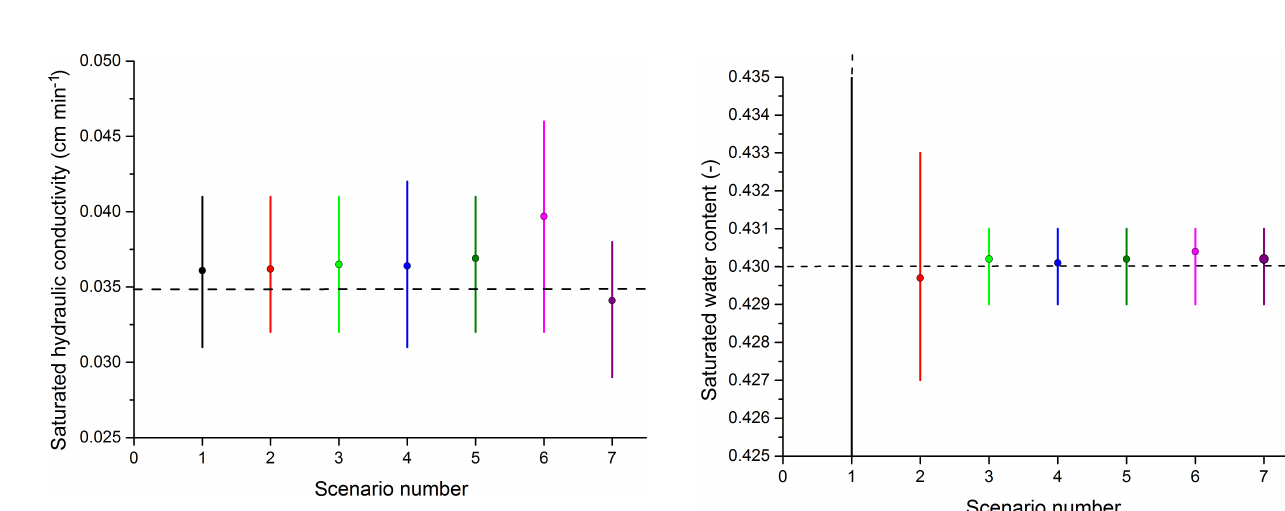
Figure 8. MCMC solutions for transport scenario 7 (see Fig. 2 caption).